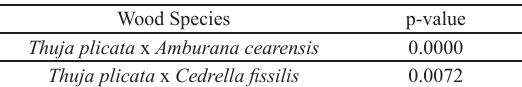
Table 6. Relation between extractive content.